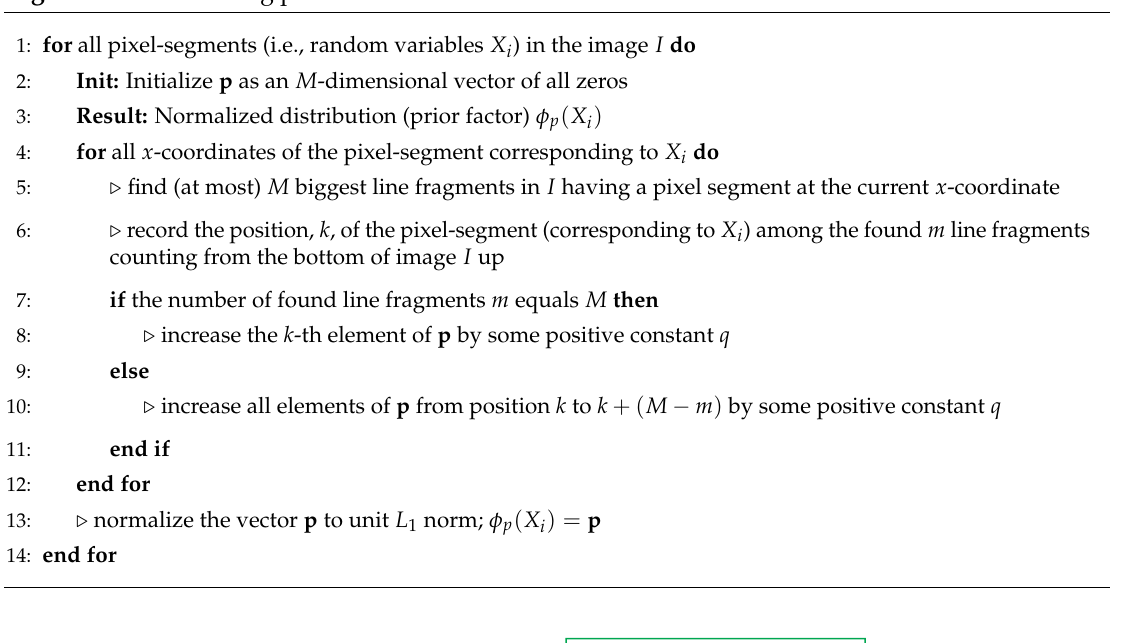
Algorithm 1 Calculating prior factors